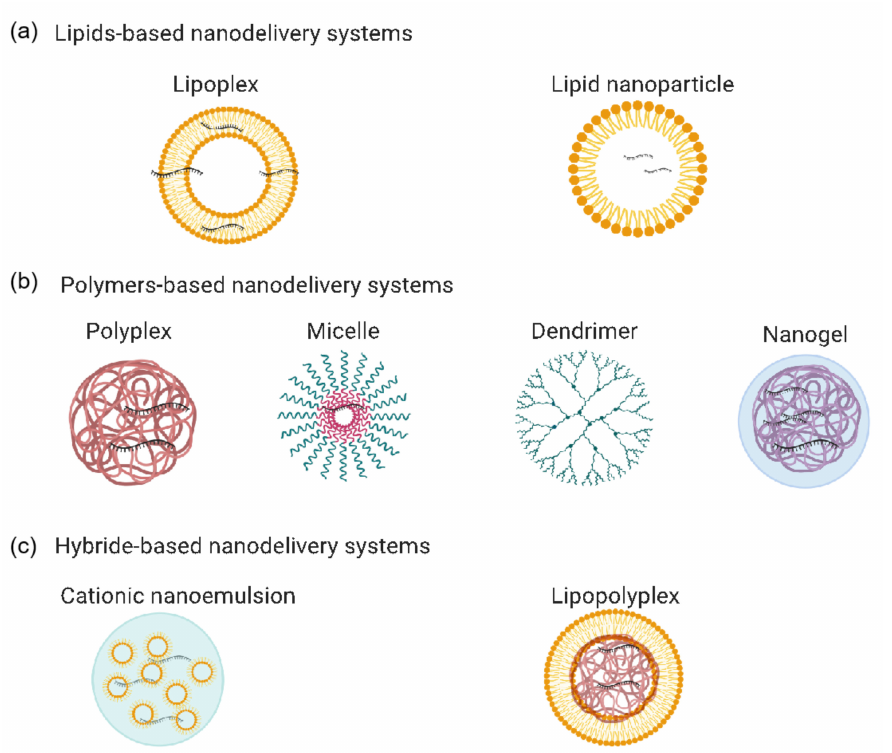
Figure 3. mRNA-based vaccine nanodelivery systems: ( a ) lipid-based nanodelivery systems, in- cluding lipoplexes and lipid nanoparticles; ( b ) polymer-based nanodelivery systems, including polyplexes, micelles, dendrimers, and nanogels; ( c ) hybrid-based nanodelivery systems, including cationic nanoemulsions and lipopolyplexes. The figure was generated using